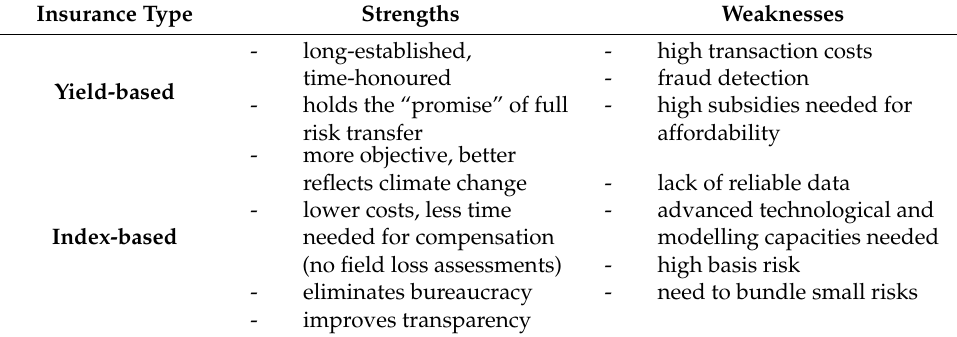
Table 2. Yield-based vs. index-based